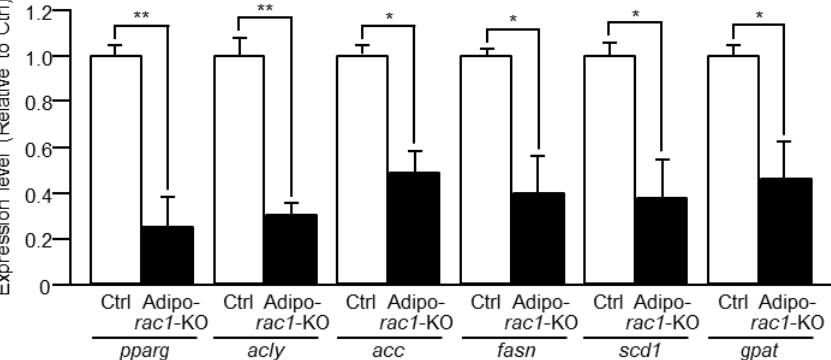
Figure 9. Reduced expression of genes encoding lipogenic enzymes in rac1 -KO sWAT. Relative expression levels in rac1 -KO sWAT were determined by quantitative RT-PCR analysis. Data are shown as means ± S.E. ( n = 6). * P < 0.05, ** P < 0.01.